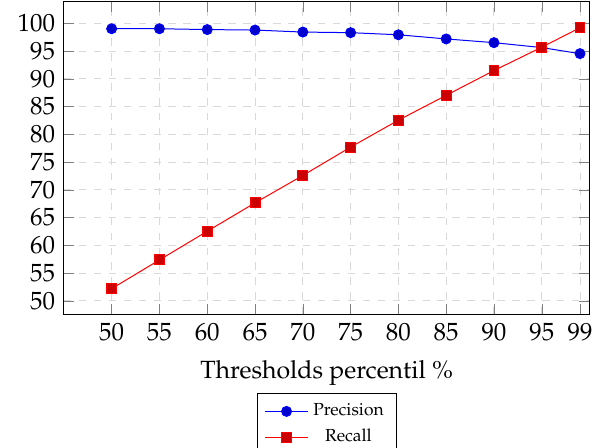
Figure 11. First experiment—isolating class 0 from Y = “Sentiment” in Logistic Regression output using LOF.